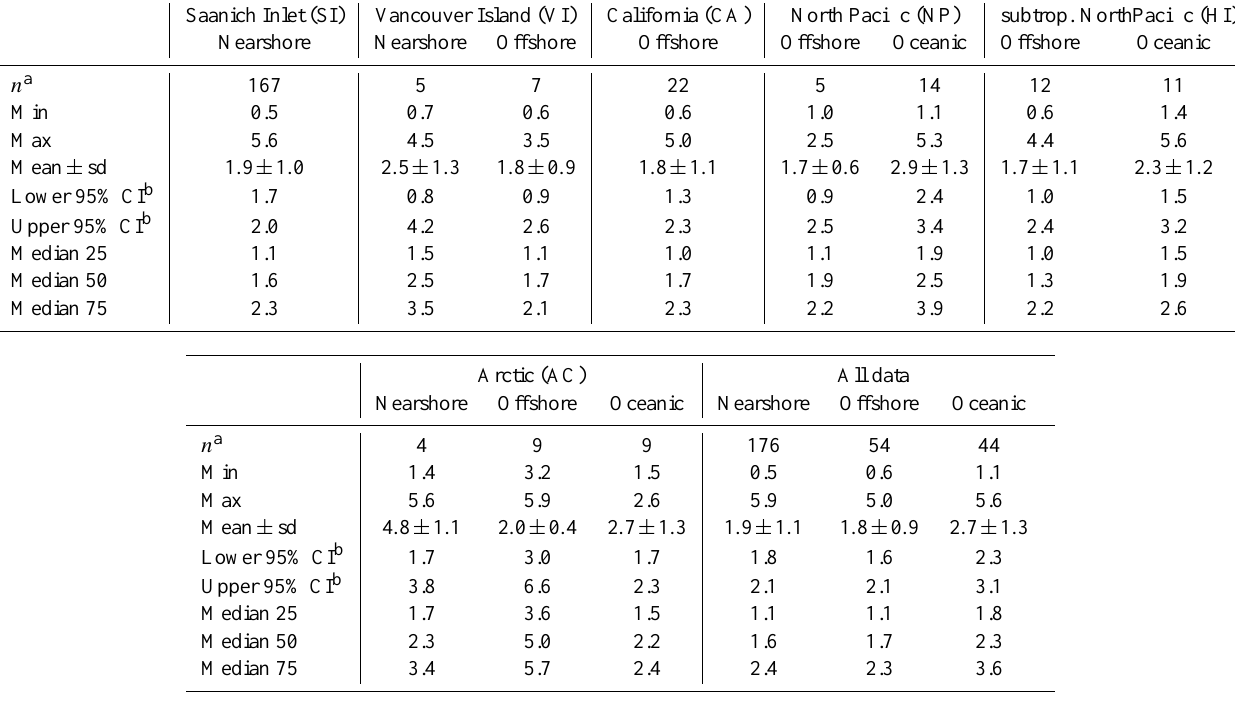
Saanich Inlet (SI) Vancouver Island (VI) California (CA) North Pacific (NP) subtrop. NorthPacific (HI) Nearshore Nearshore Offshore Offshore Offshore Oceanic Offshore Oceanic n a 167